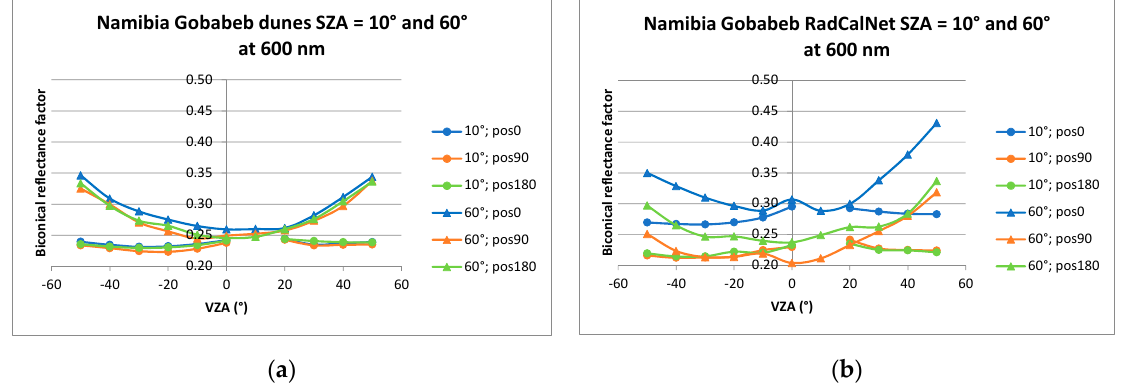
Figure 14. BCRF for the minimum (10°) and the maximum (60°) solar zenith angles, in the principal plane, for Namibian sites near Gobabeb: ( a ) dunes; ( b ) RadCalNet.